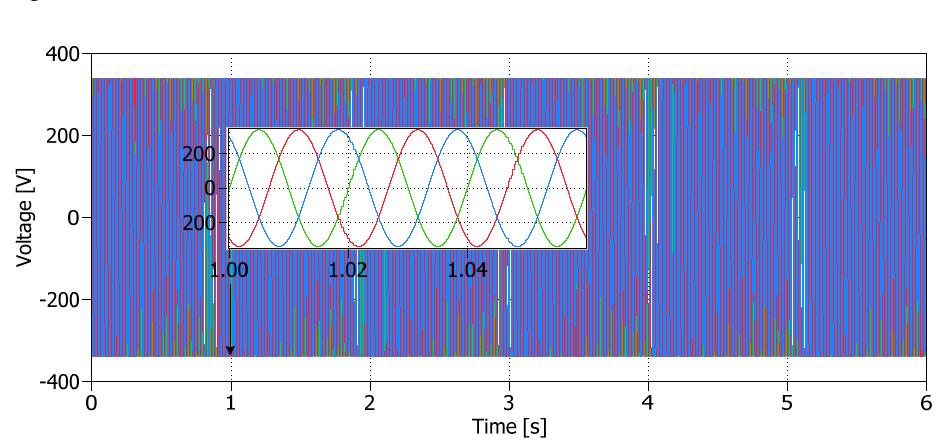
Figure 4. Grid current.